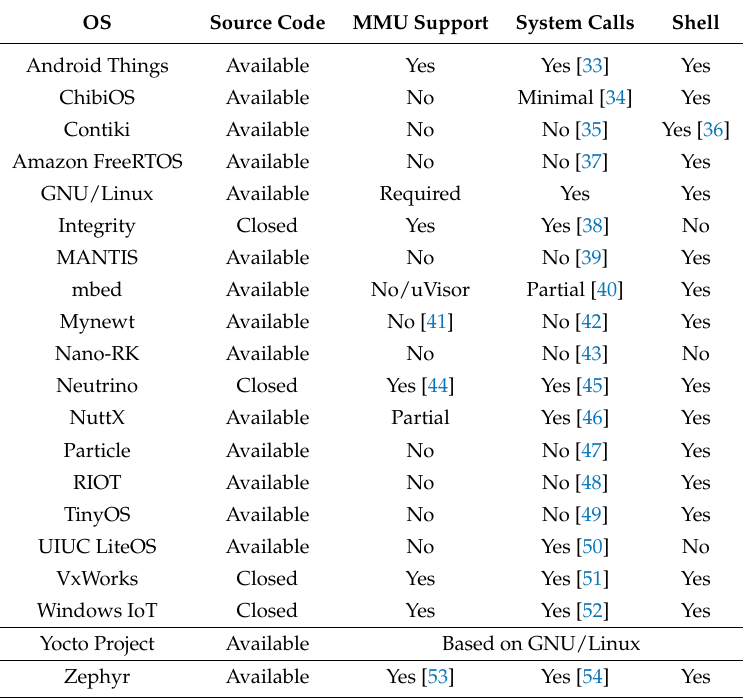
Table 1. The diversifiable interfaces in various IoT operating